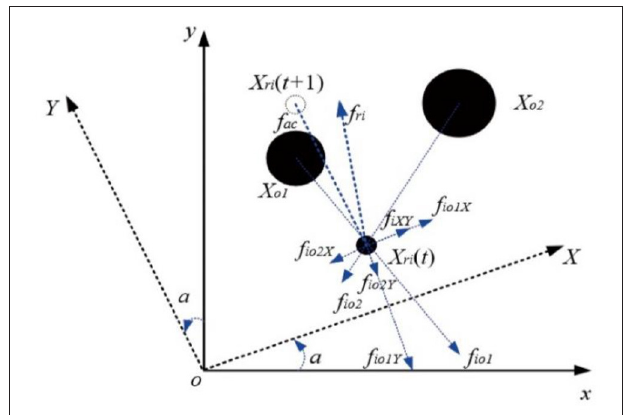
FIGURE 2 | SVFM obstacle avoidance